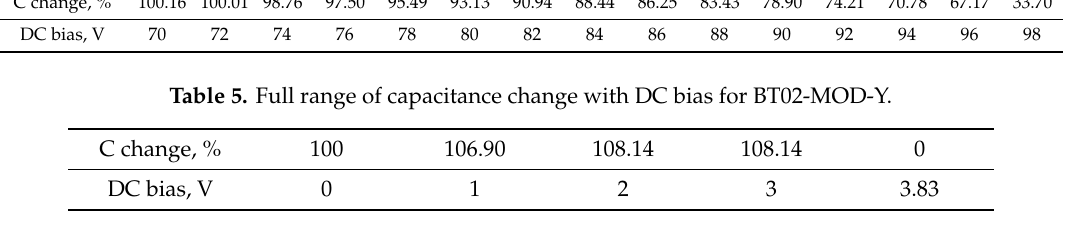
Table 6. Increase range of capacitance with DC bias for